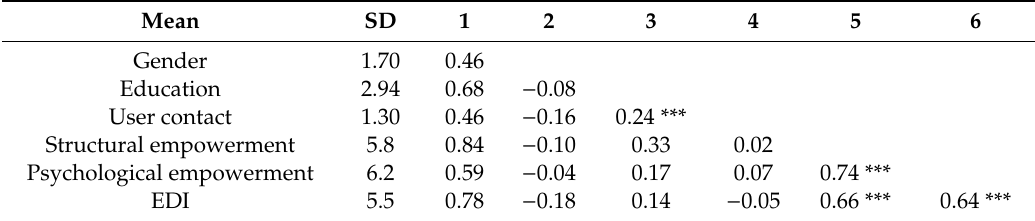
Table 1. Mean, Standard deviation and scale